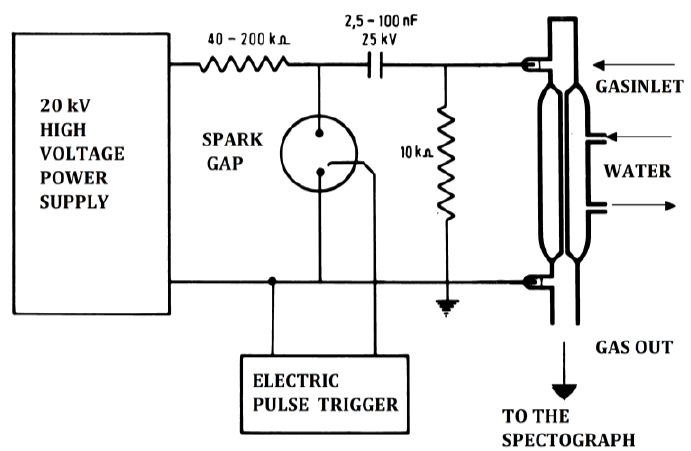
Figure 1. Schematic of the electric circuit. Reproduced and modified by permission of IOP Publishing from [16]. (© The Royal Swedish Academy of Sciences. All rights reserved.)